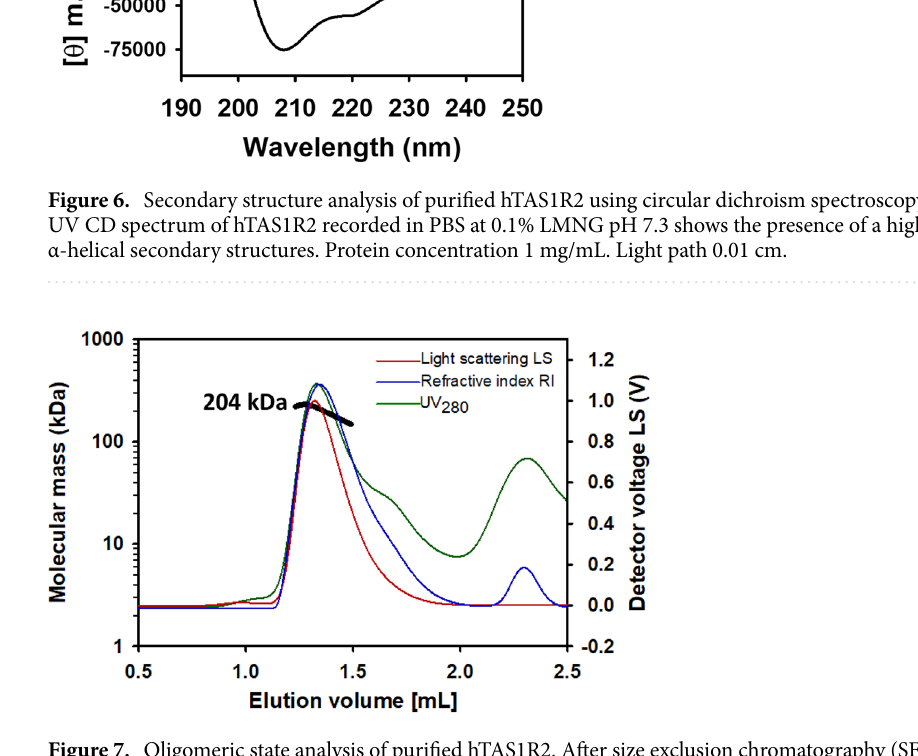
Figure 7. Oligomeric state analysis of purified hTAS1R2. After size exclusion chromatography (SEC) and separation with a Superdex 200 3.2/300 column (GE Healthcare), the molecular mass was determined from the Raleigh ratio, measured by static light scattering and the refractive index. The calculated molecular mass (bold black curve), refraction index (blue curve), light scattering (red curve) and UV at 280 nm (green curve) are shown. A main oligomeric form with a measured mass of 204 kDa was detected, indicating the presence of a dimeric hTAS1R2 form associated with